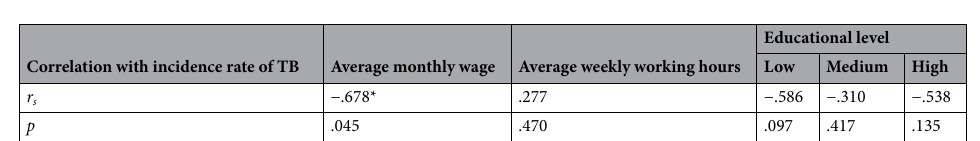
Table 4. Correlation between incidence rate of TB with average monthly wage, average weekly working hours and educational level among workers of Makkah region 2016.